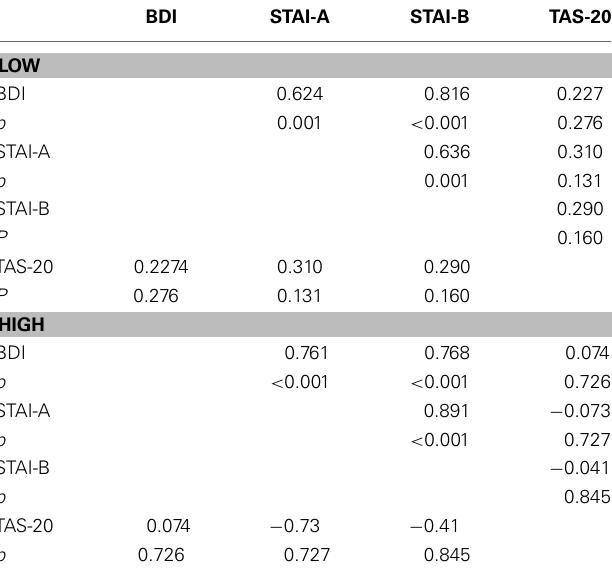
Table 4 | Correlations between the different covariates according to the